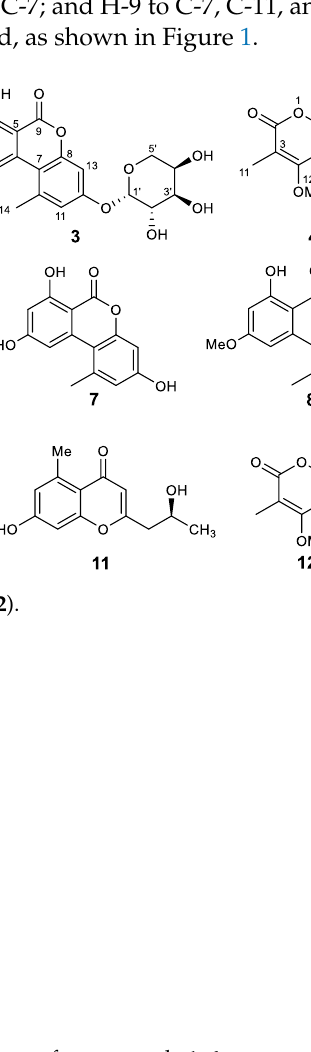
Figure 2. Key 1 H- 1 H COSY and HMBC correlations of compounds 1 – 4 .